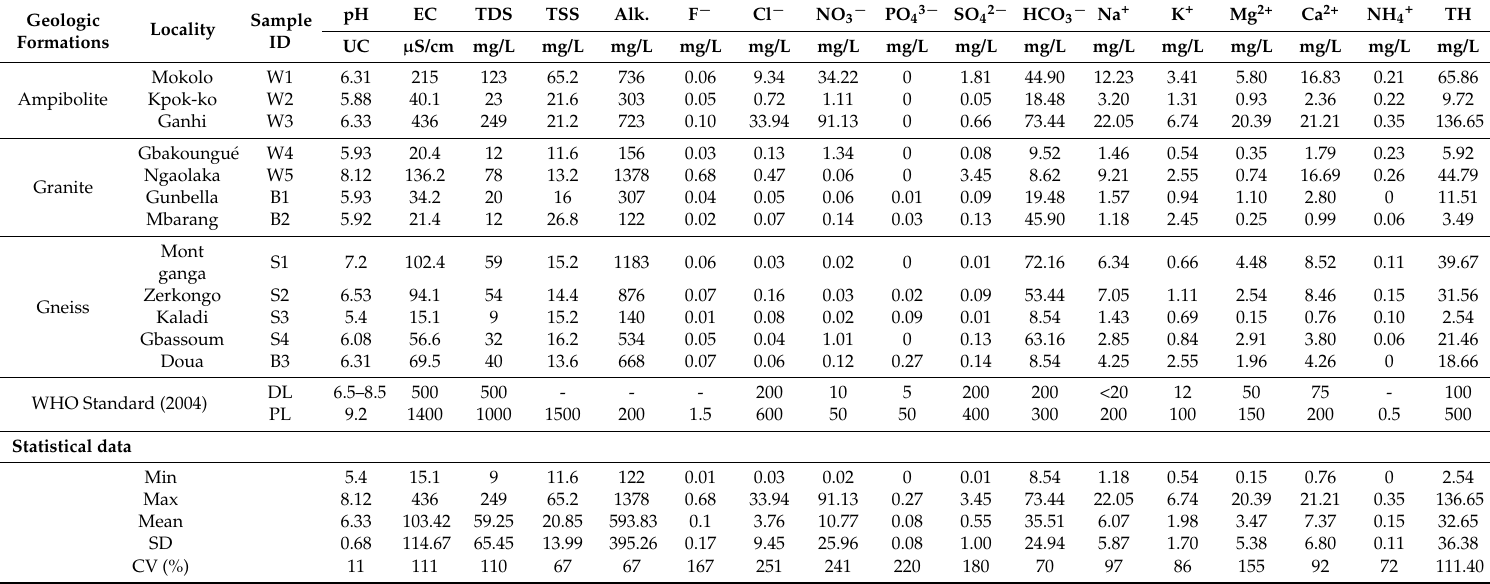
Table 4. Physicochemical results of water